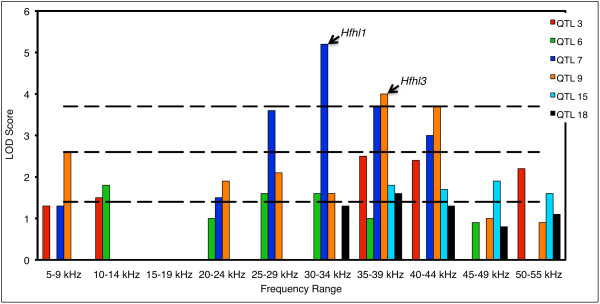
Frequency specificity of C3H-N2 QTLs. The heights of the vertical bars indicate the LOD scores calculated for QTLs that affect one or more of the 10 segments into which the DPOAE spectrum was divided. Only those QTL that were first identified in the marker regression analyses of the C3H-N2 population using PC1 or HFEA as the quantitative trait are shown. Each color represents a particular locus and the number given for the QTL indicates the chromosome on which the QTL was detected. Dashed lines indicate the permutation derived genome-wide significance levels for suggestive, significant, and highly significant linkage. No bars are shown in cases for which the p value of the LOD score exceeded 0.05.